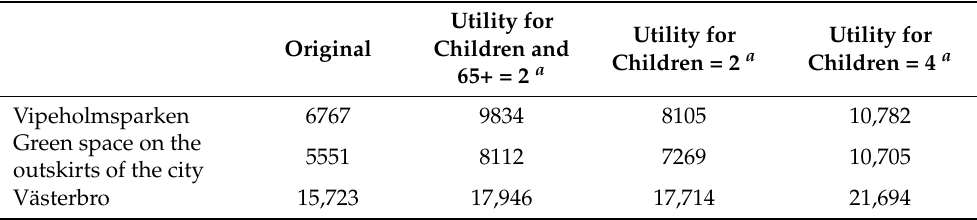
Table 6. Utility when using the assumption that children and individuals aged 65 years and above have higher utility than in the original analysis. Utility for